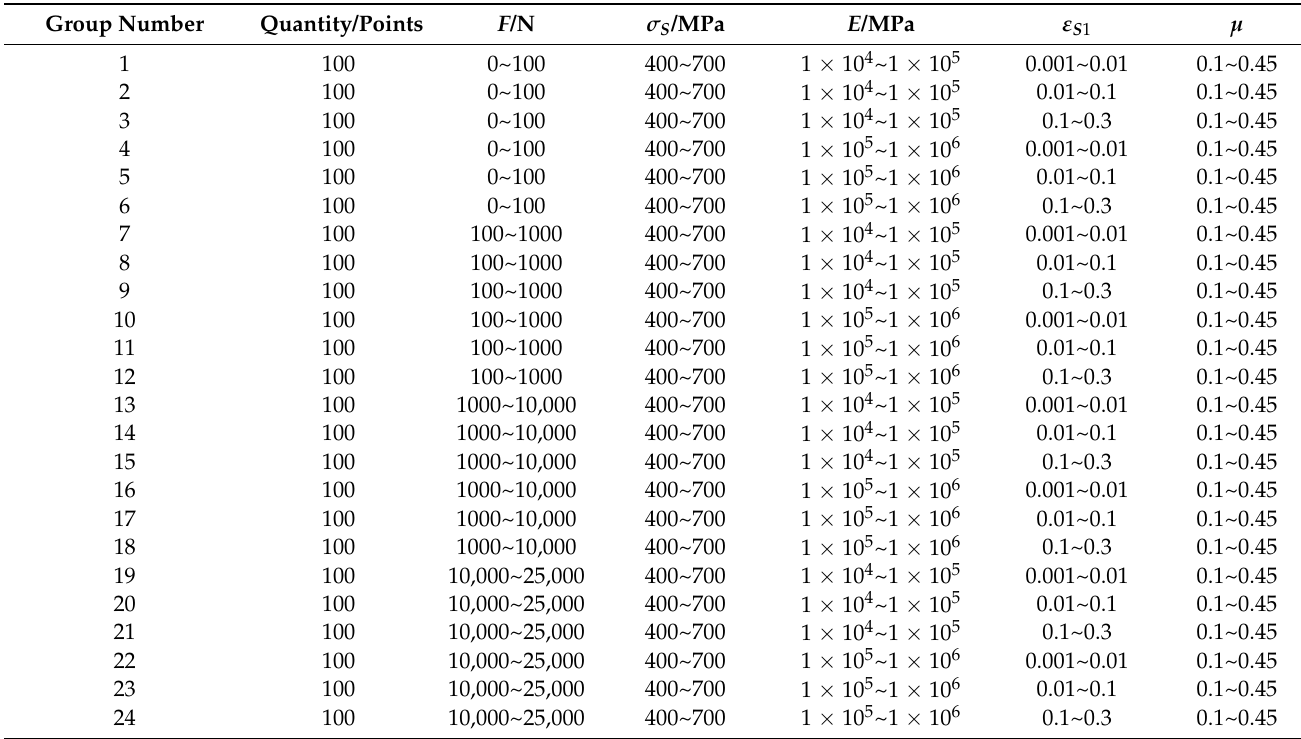
Table 1. Sampling groups.